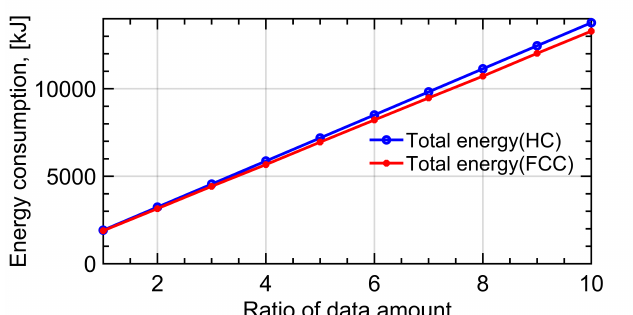
Figure 11. The variation in propulsion energy with the change in IoT user’s data amount. The blue line represents the variation in propulsion energy for HC trajectory when the amount of data increases from 1 to 10 times. The red line denotes variation in propulsion energy for FCC trajectory.